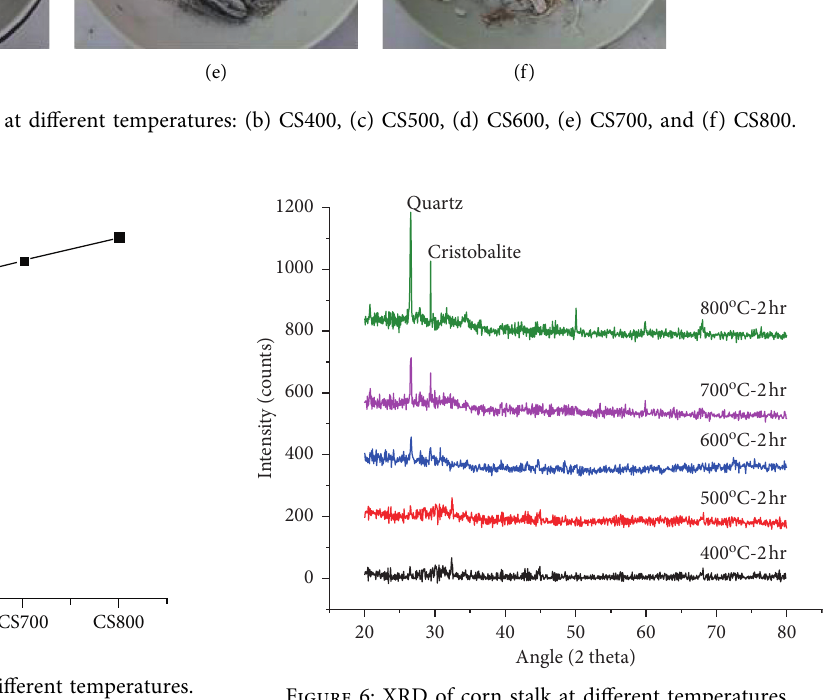
6: XRD of corn stalk at different